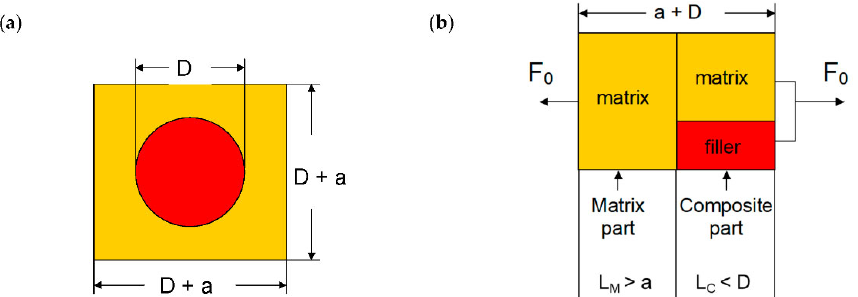
Figure 2. ( a ) Cubic elementary volume (EV) with edge length D + a containing spherical inclusion of diameter D ; a denotes distance between neighboring inclusions. ( b ) Separation of EV into matrix part and composite part containing now cubic inclusion according to [26] with the external load F 0 .